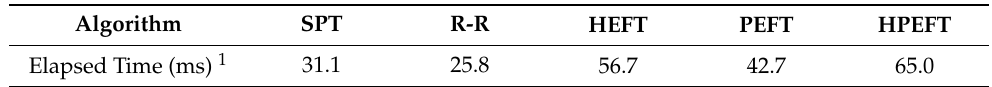
Table 11. Elapsed time of test